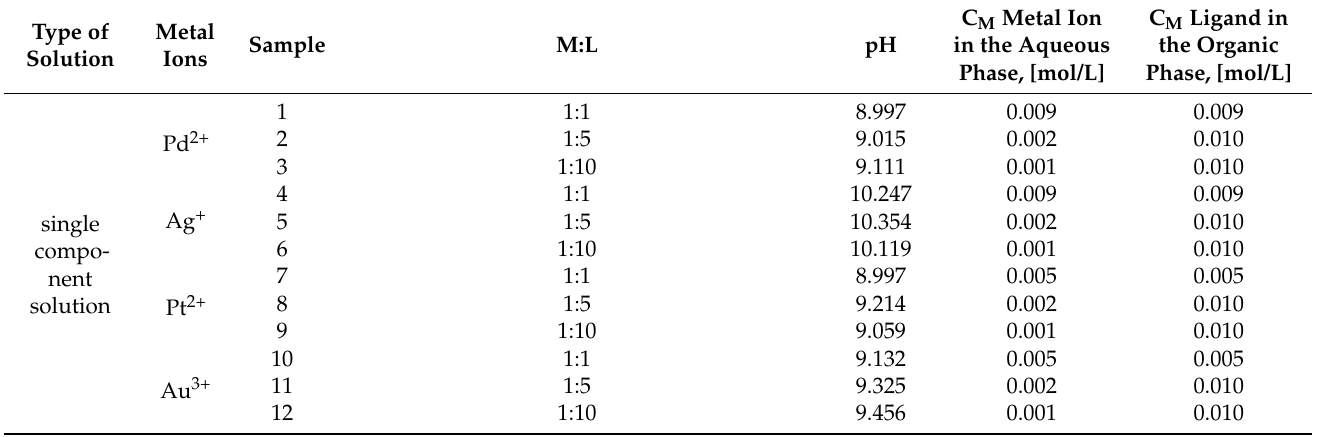
Table 1. The parameters of the particular phases in the extraction